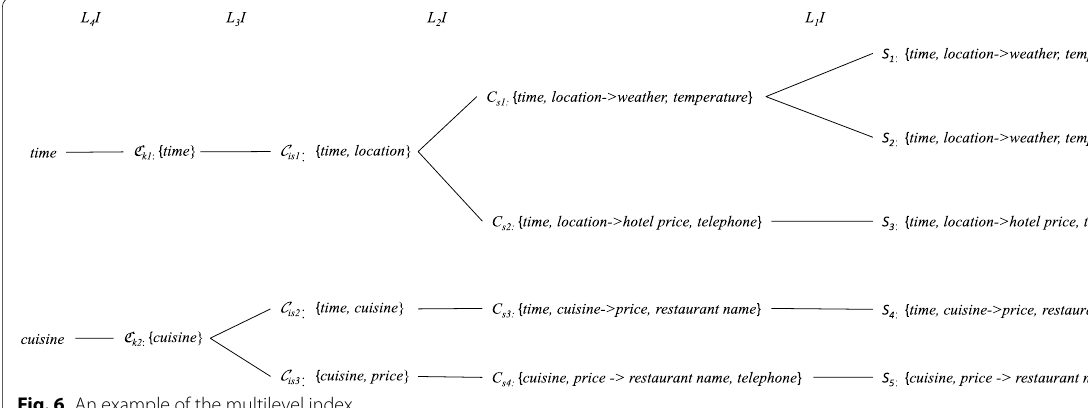
Fig. 6 An example of the multilevel index